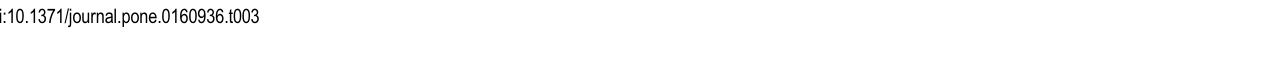
Table 3. Bornavirus detection by RT-PCR from wild and captive Passeriformes in Germany, 2011 – 2016. Family year of sampling pos. / total samples Species wild birds captive birds True fi nches (Fringillidae) Common canary ( Serinus canaria f. dom.) - 11 / 48 others Estrildid fi nches (Estrildidae) Old World warblers